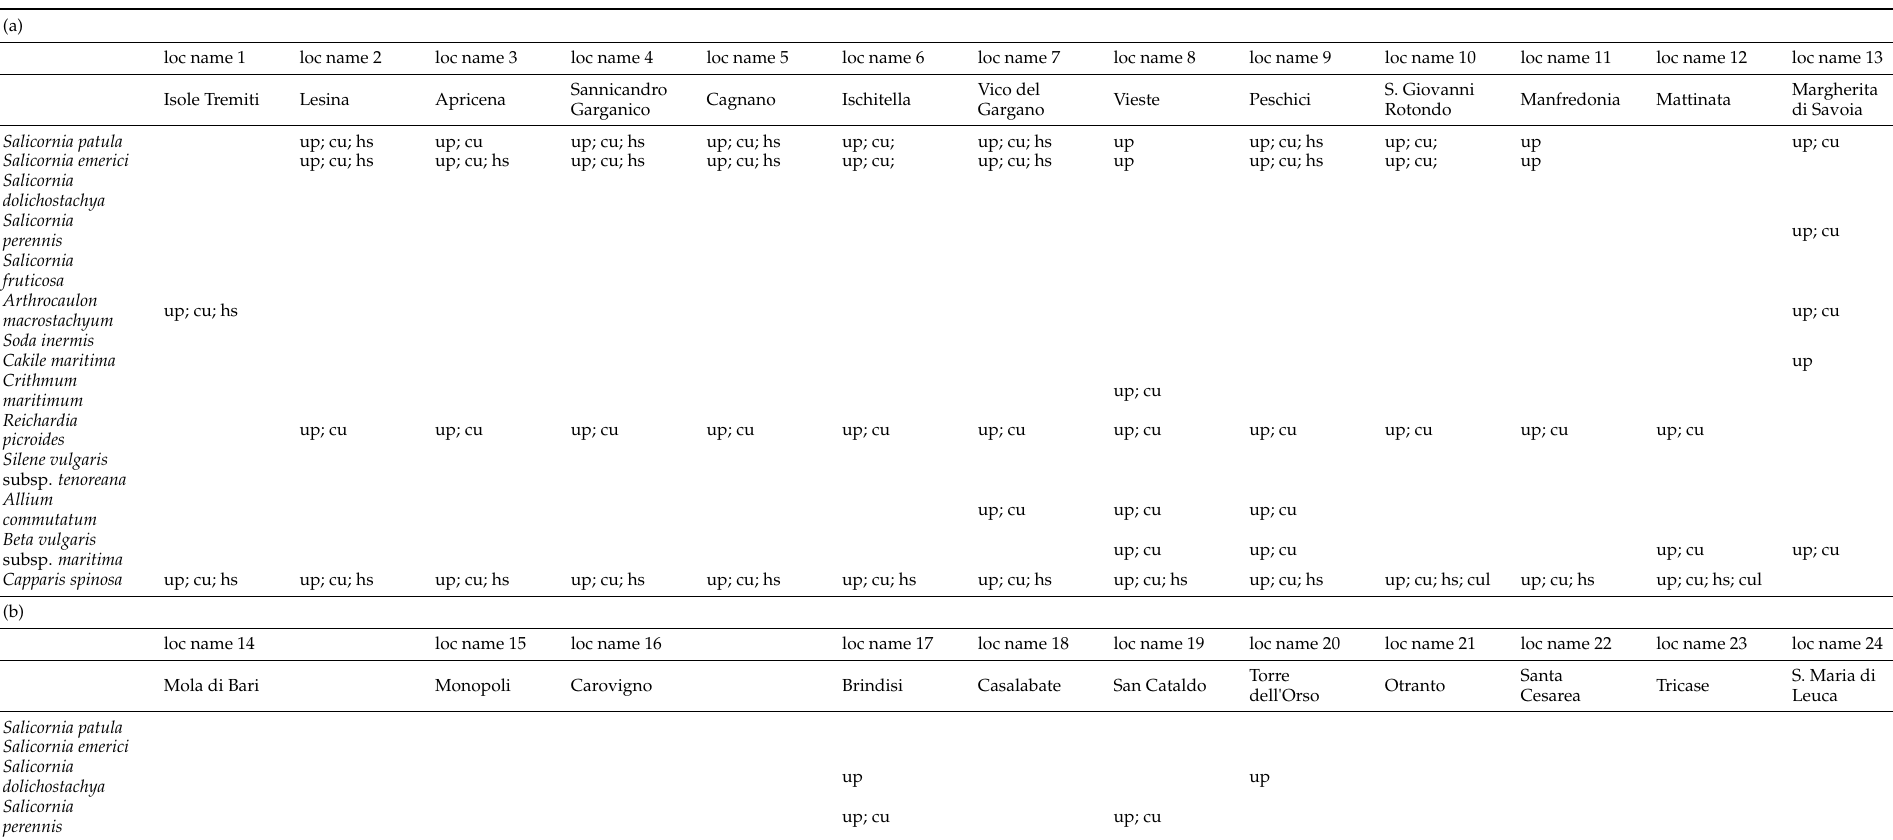
Table A1. a–c : Distribution, across the Apulia region, of the use (food use; sale; domestication; cultivation) of the halophytes and halotolerant species treated in this contribution, according to our field observations and the literature